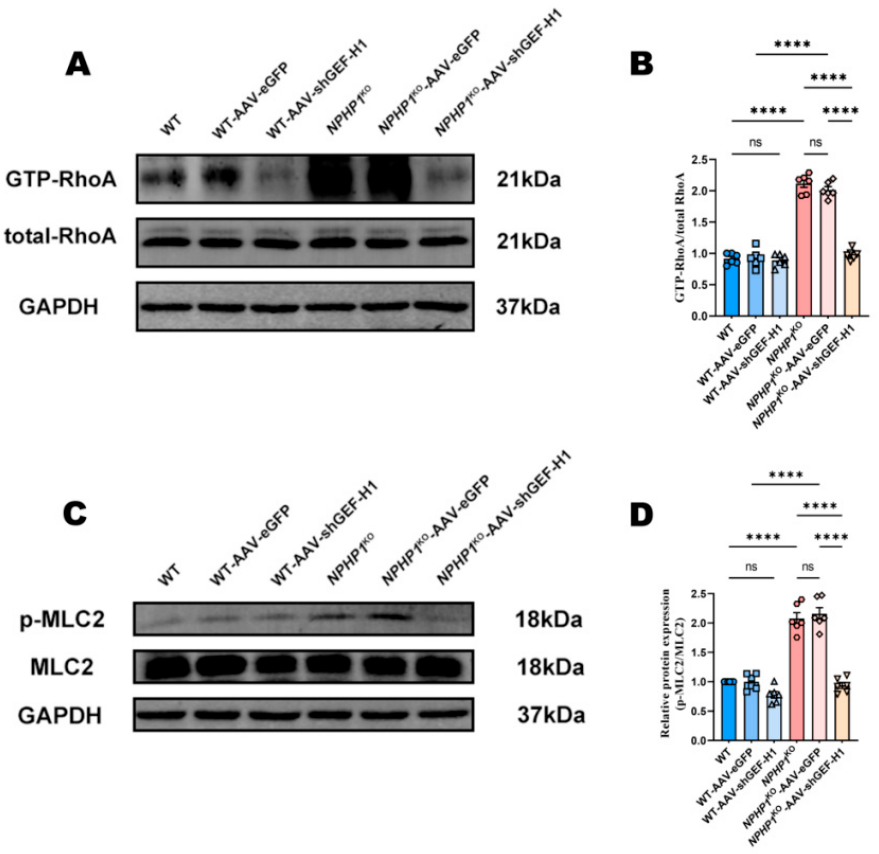
Figure 5. GEF-H1 knockdown blocked the activation of RhoA and the phosphorylation of MLC2 in NPHP1 KO mice. ( A , B ): The expression of RhoA activation in different mice groups. ( A ): Western blot, ( B ): Densitometry analysis; n = 6 mice/group). ( C , D ): The phosphorylation of MLC2(p-MCL2) in murine kidneys; p-MCL2 was upregulated in the kidneys of NPHP1 KO mice compared with that in WT mice. After GEF-H1 knockdown, this upregulation was decreased in NPHP1 KO mice. ( C ): Western blot, ( D ): Densitometry analysis; n = 6 mice/group). Data represent the mean ± SEM. **** p < 0.0001; ns, no significance.